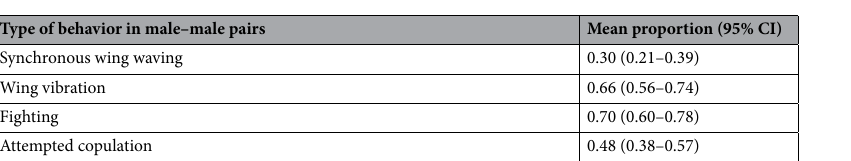
Table 2. Proportion (mean and CI) of males exhibiting antagonistic behaviors in male–male pairs. Fighting: % of pairs engaging in this behavior during the observation period. Synchronous wing waving, wing vibration, attempted copulation: % of individual males engaging in the